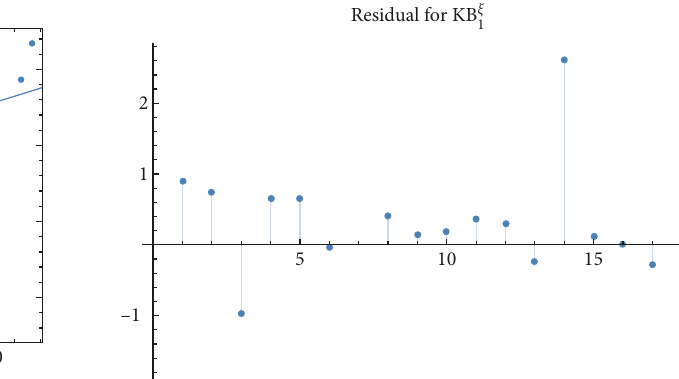
Figure 10: Plot shows the residuals for S on KB ξ